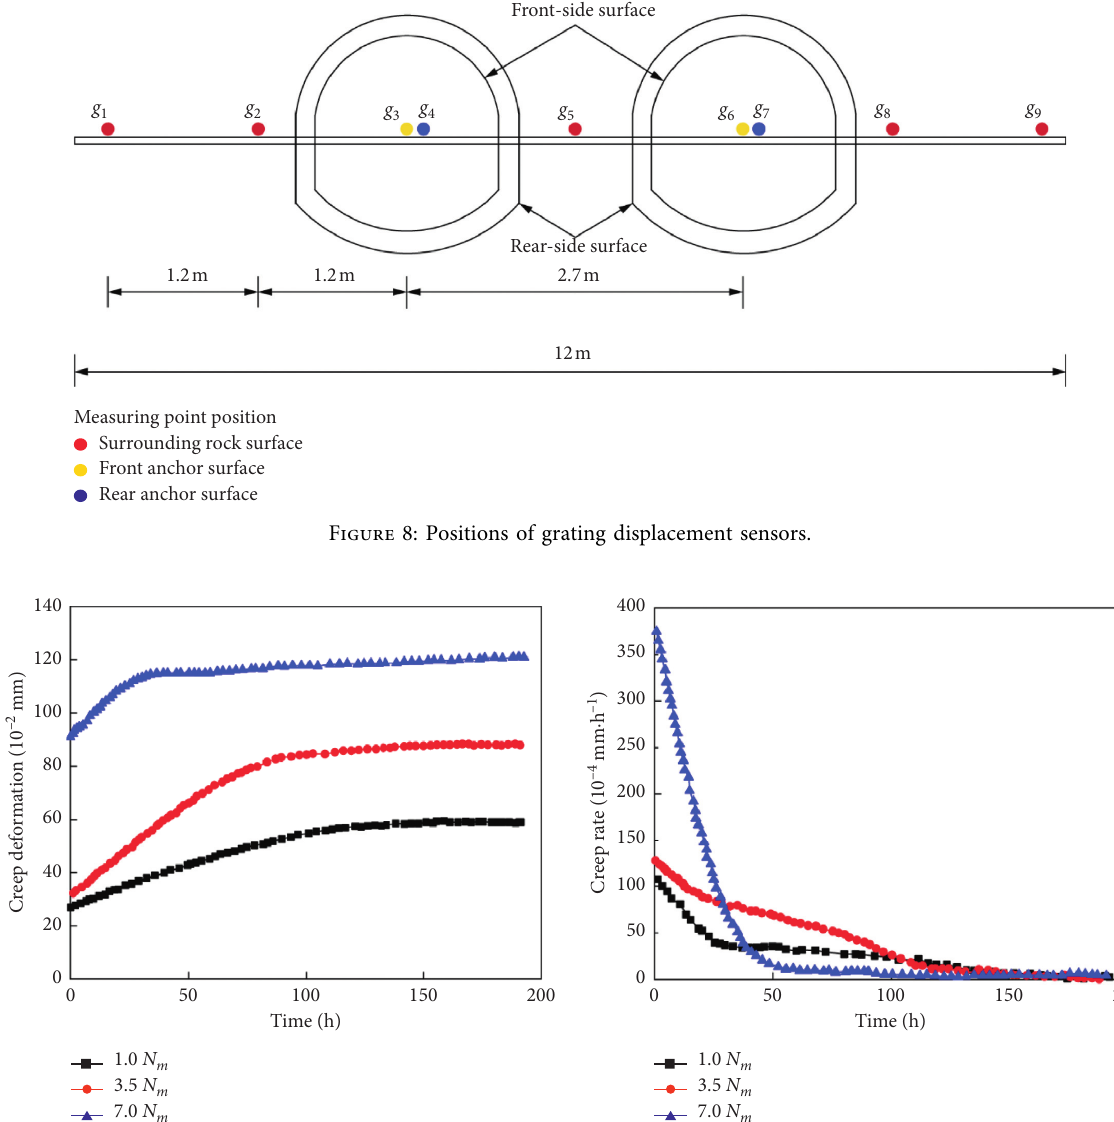
measured during creep 7